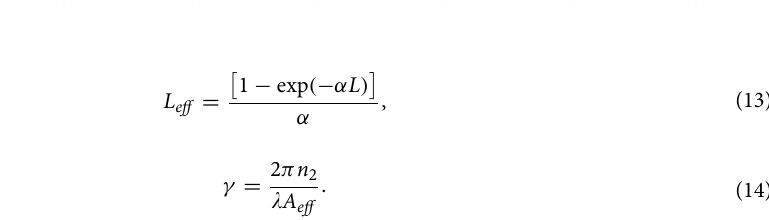
Figure 4. Simulated waveguide dispersion for waveguide width of 0.8 µm and film thickness 310 nm ( — ), 400 nm ( — ), 500 nm ( — ), and 600 nm ( —